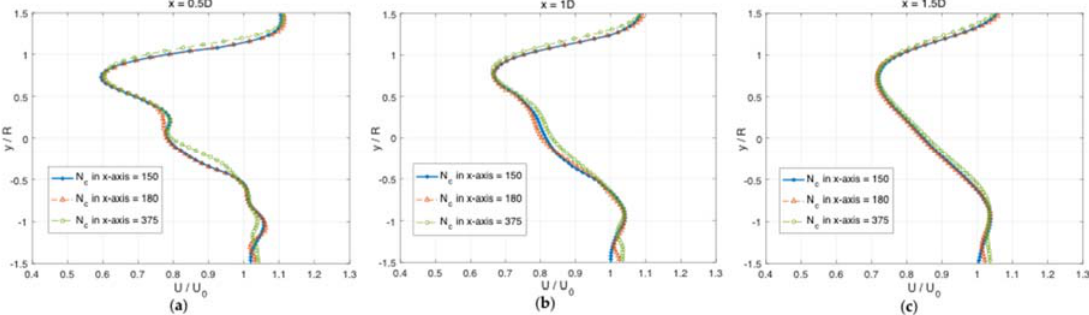
Figure A2. Horizontal profiles computed on three meshes of normalised mean stream-wise velocity component at turbine mid-height where z / H = 0 at ( a ) x = 0.5 D , ( b ) x = 1 D , and ( c ) x = 1.5 D .